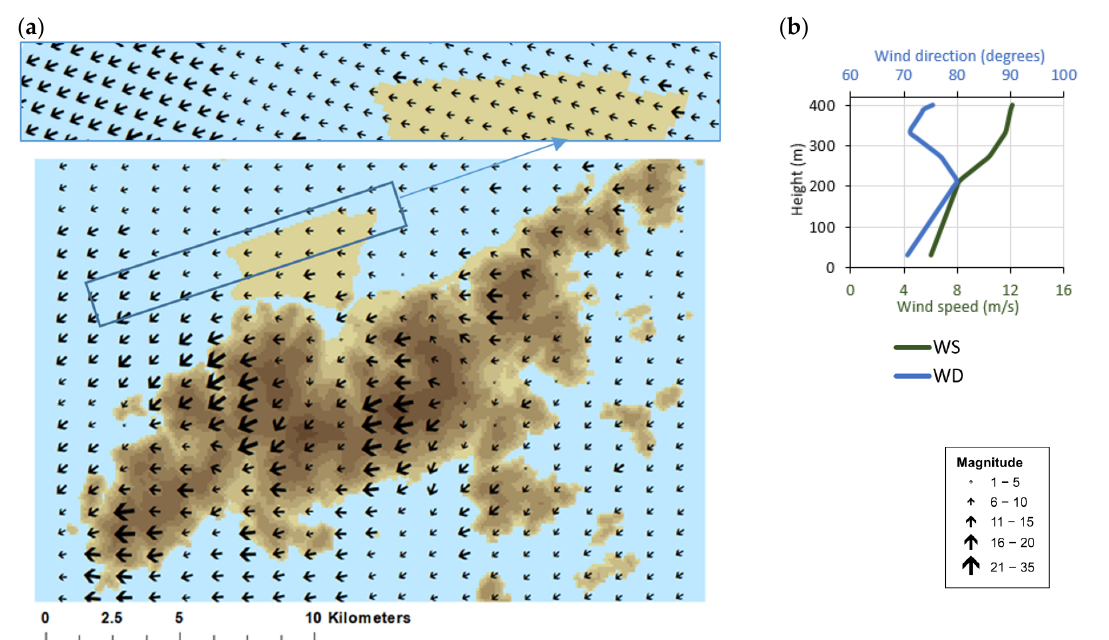
Figure 6. Derivation of metrics for a wind event occurring on 7 January 2018 coinciding with 07LA (event time 09:25, local time zone, modelled time 09:05, local time zone): ( a ) modelled minimum and maximum vertical acceleration, ( b ) modelled headwind on vertical slice, ( c ) modelled minimum and maximum horizontal acceleration. Selected wind observations at CCH (every 100 m) are displayed as wind barbs (in knots) to the right of the headwind vertical slice.